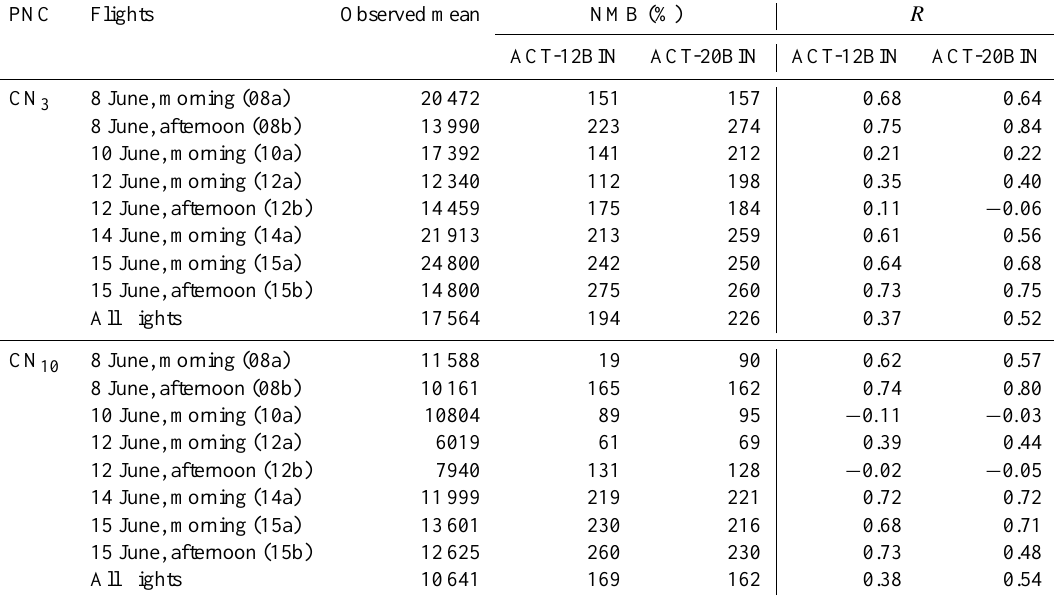
Table 9. Summary statistics for CN 3 and CN 10 when using the ACT parameterization in a sectional framework with different numbers of particle size bins. The observed mean, normalized mean bias (NMB) and correlation coefficient ( R ) are calculated between simulated and observed number concentrations collected during the CARES G-1 aircraft